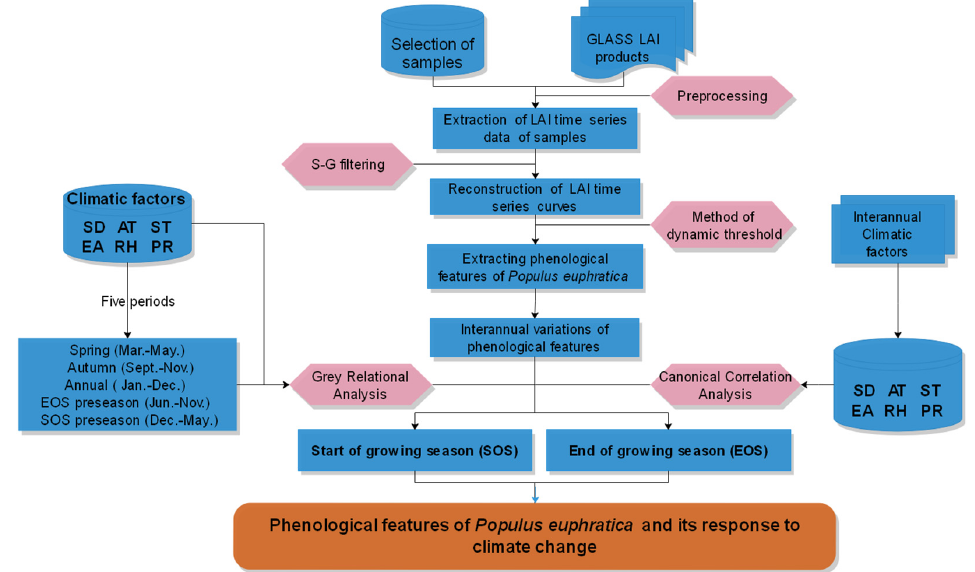
Figure 2. Schematic diagram of the extraction processes of henological features of P. euphratica . Abbreviations: Leaf area index (LAI), Global Land Surface Satellite (GLASS), sunshine duration (SD), average air temperature (AT), average land surface temperature (ST), effective accumulated temperature (EA), average relative humidity (RH), precipitation (PR), start of the growing season (SOS), end of the growing season (EOS), Savitzky-Golay (S-G) filtering.